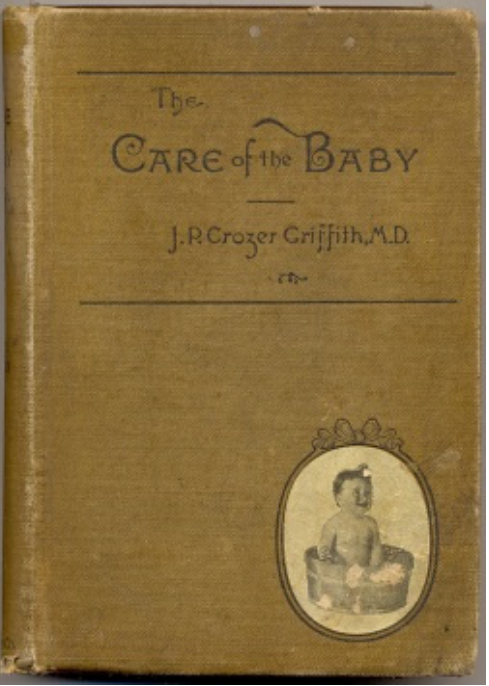
Figure 30. Outside Cover of Griffith’s 1921 The Care of the Baby.